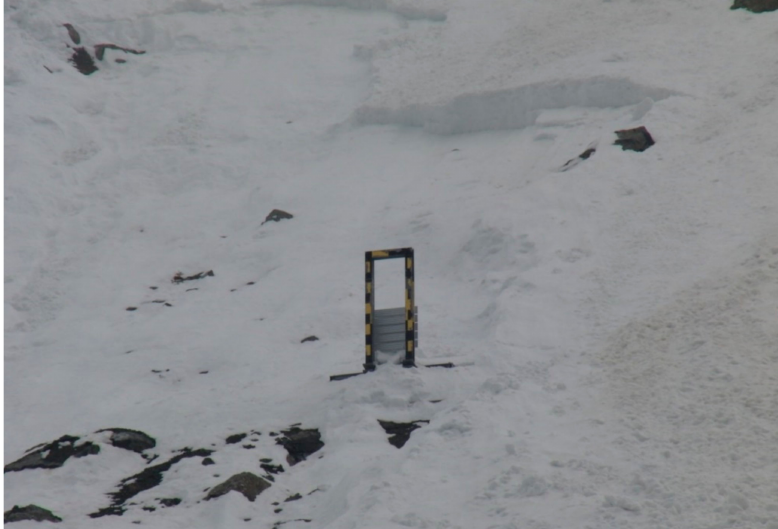
Figure 8. View of the obstacle from below after the event on 17 April 2013. The fracture line of the released slab is clearly visible. Photo L. Pitet on April